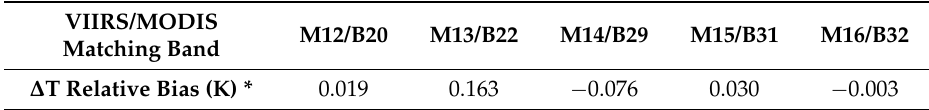
Figure 8. RSR Curves for matching TEB for VIIRS and MODIS.